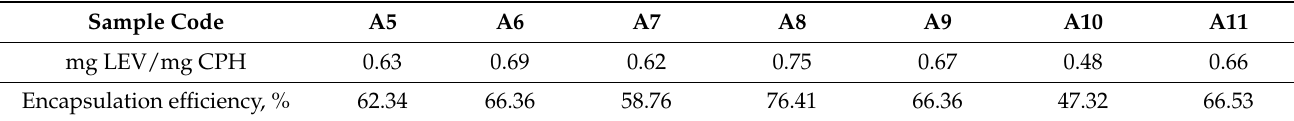
Table 3. Encapsulated LEV and